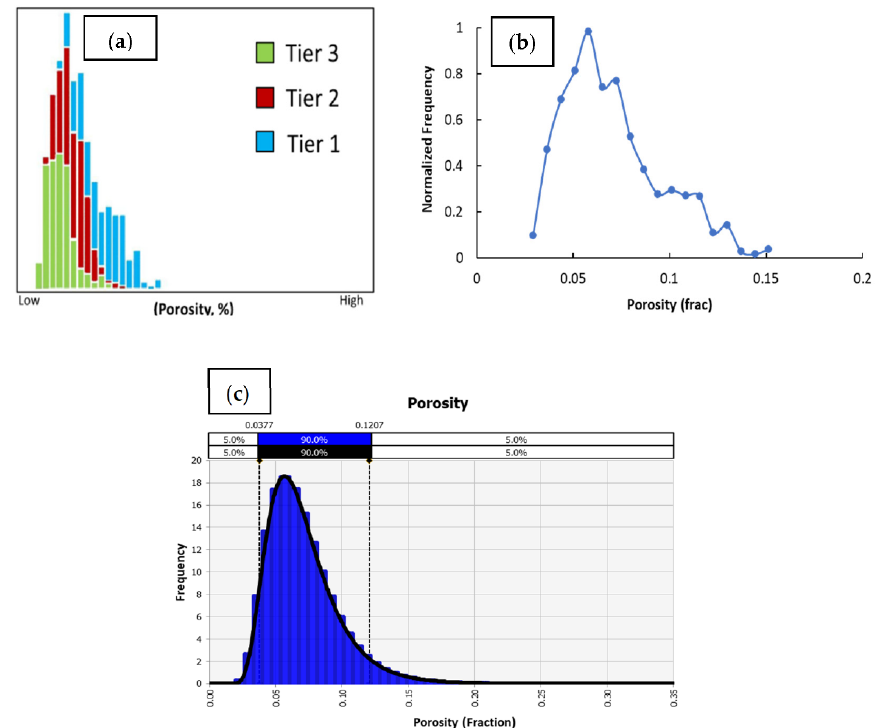
Figure 6. ( a ) Qualitatively scaled porosity distribution of Jafurah Basin [17,18]. ( b ) Normalized frequency obtained by digitization of ( a ) plotted with the midpoint of each histogram porosity column. ( c ) Adopted porosity distribution.